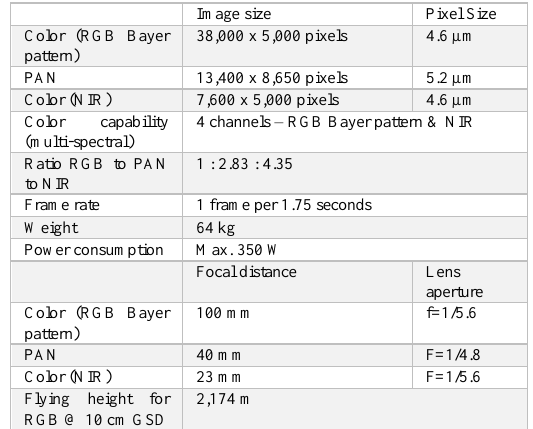
Fig 3: Cone layout of the UltraCam Condor (top) and footprint extend for PAN, RGB and NIR